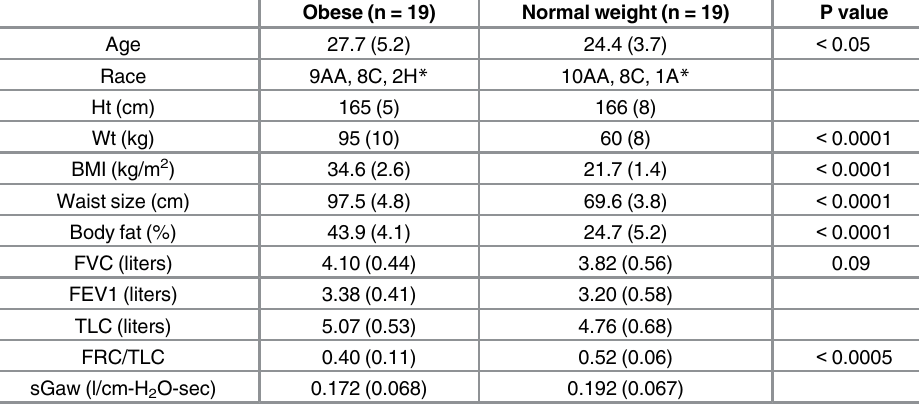
Table 2. Summary mean (SD) of subject anthropometric and baseline lung function